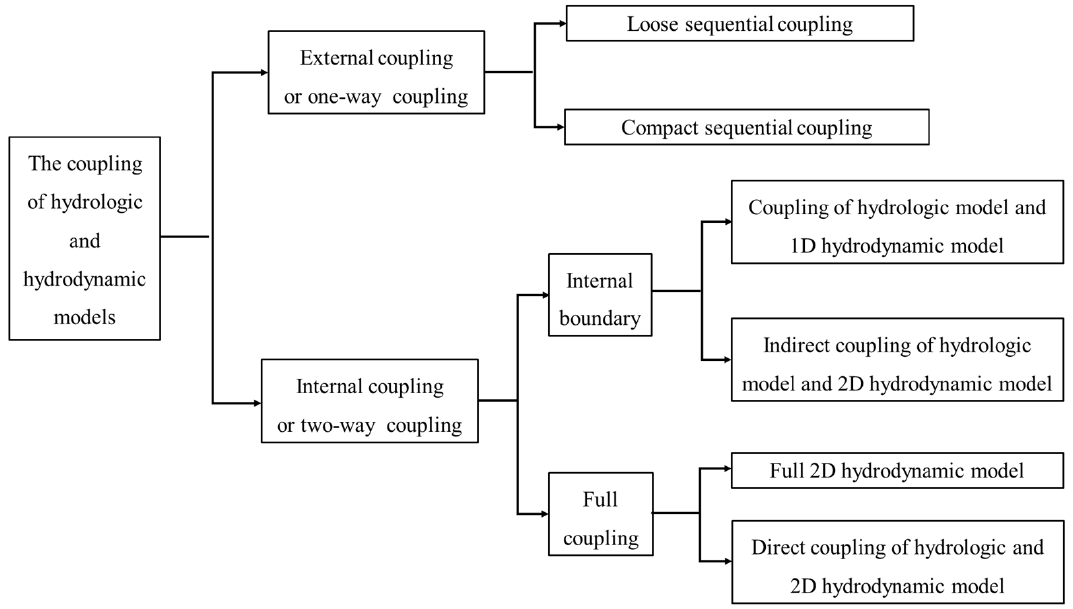
Figure 1. The classification of the coupling of the hydrologic and hydrodynamic models.